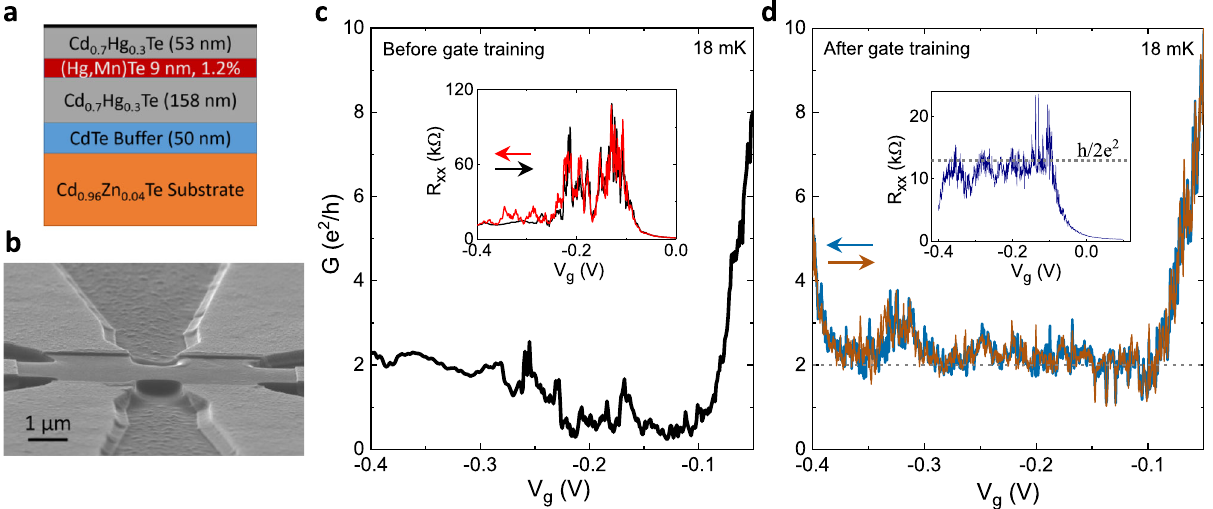
Fig. 2 Quantized spin Hall conductance in a (Hg,Mn)Te quantum well. a Schematic of the layer stack showing the (Hg,Mn)Te quantum well sandwiched between two Cd 0.7 Hg 0.3 Te barriers on a Cd 0.96 Zn 0.04 Te substrate. b Scanning electron micrograph of a typical Hall bar used for measurements. c The conductance G as a function of gate voltage V g for a 9 nm thick (Hg,Mn)Te quantum well with 1.2% Mn at 18 mK. The inset shows the longitudinal resistance R xx as a function of V g . d G as a function of V g at 18 mK after gate training. The inset shows R xx as a function of V g . The dotted line indicates the expected conductance of 2 e 2 / h in the quantum spin Hall regime. The arrows in c and d show the direction of gate voltage sweeps.